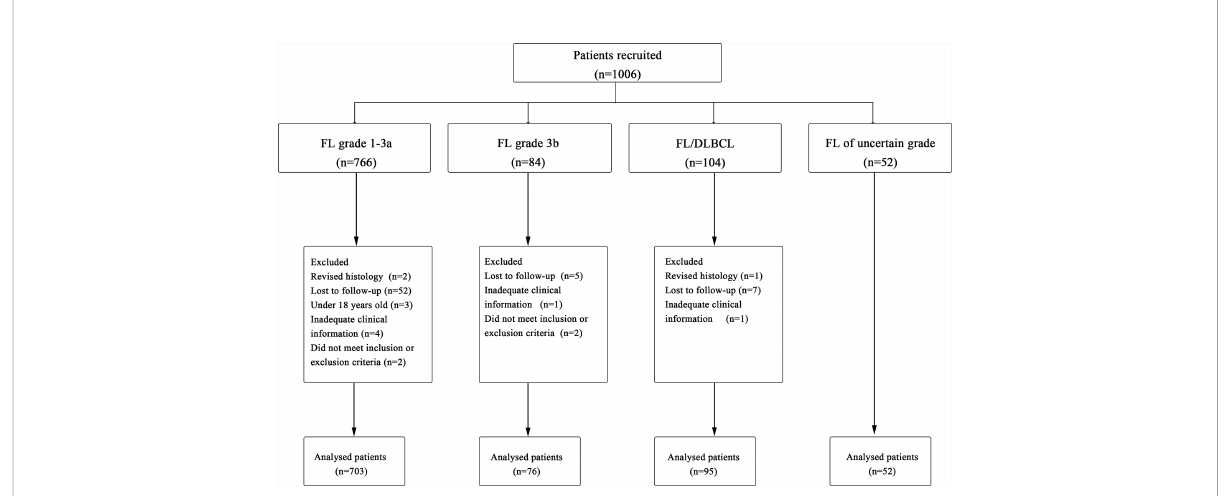
FIGURE 1 Procedure of study cohort selection and number of patients included in analysis. FL, follicular lymphoma; DLBCL, diffuse large B-cell